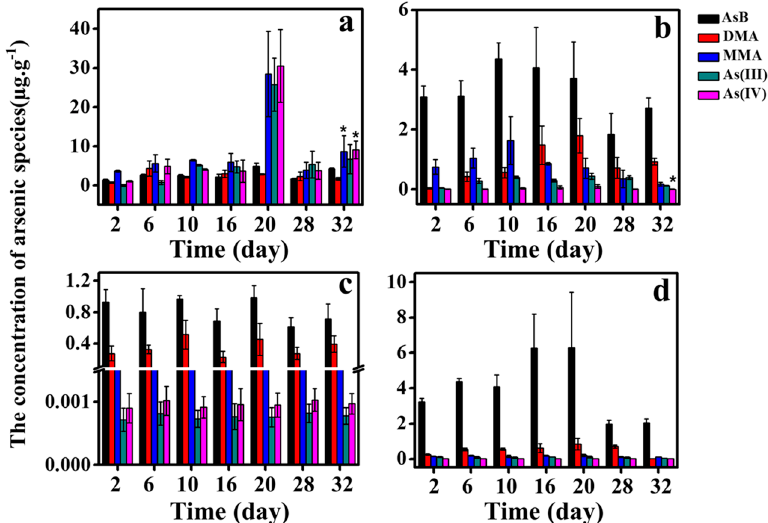
Figure 3. The concentrations of five As species (AsB, DMA, MMA, AS(III), and As(IV)) in: ( a ) intestine; ( b ) liver; ( c ) muscle; and ( d ) gill over 32 days of As(III) exposure . Analysis of variance was used to test differences of arsenic species during the experiment period and significance was marked on 32nd day ( p < 0.05).